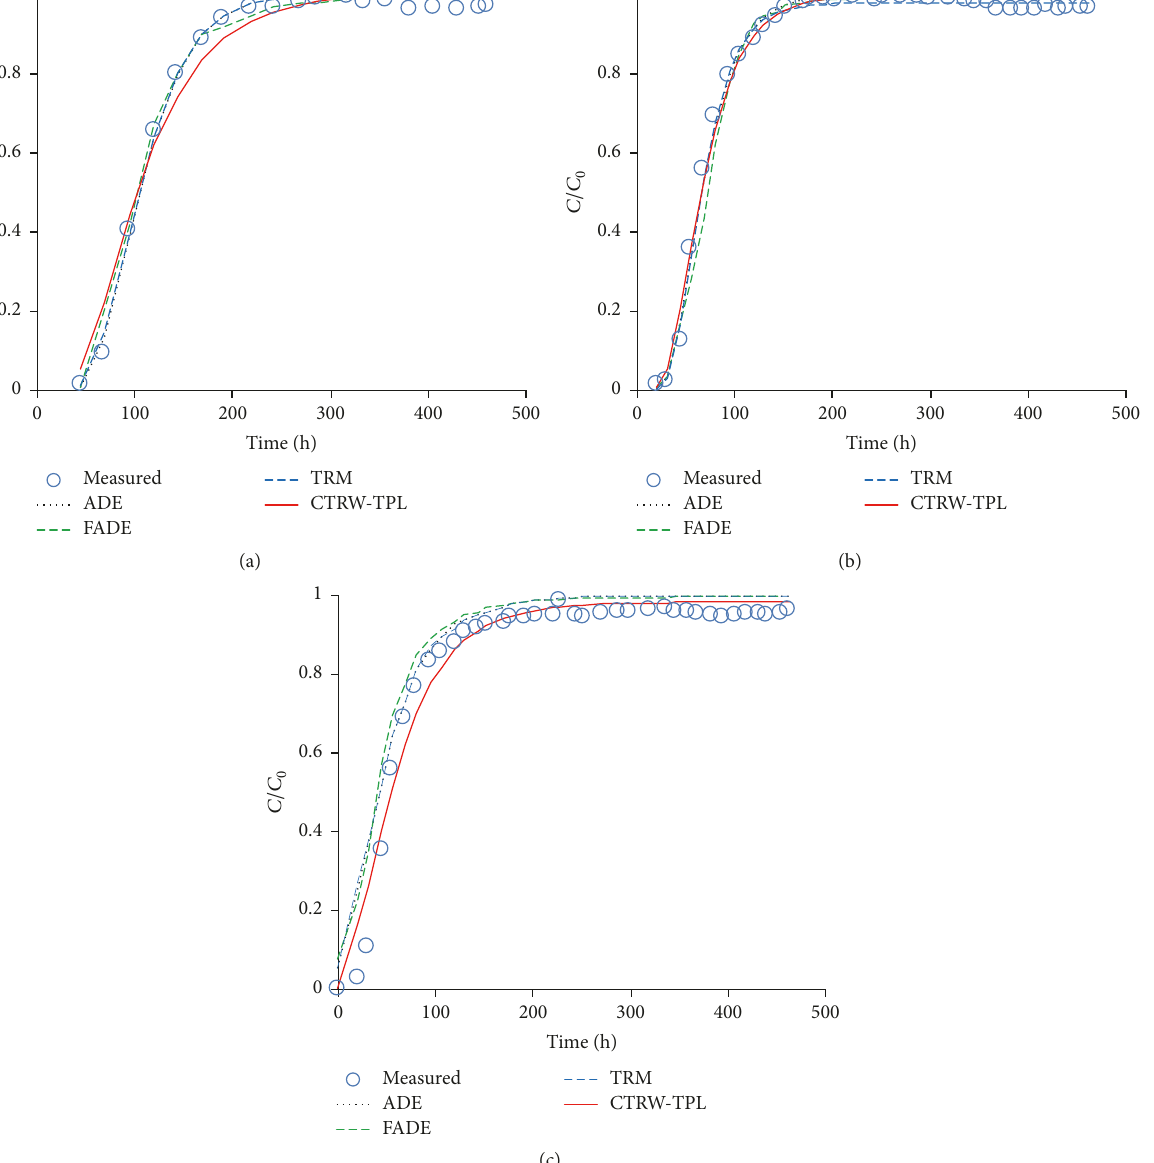
Figure 4: Three sets of measured breakthrough curves fitted with ADE, FADE, TRM, and CTRW (based on TPL), for the homogeneous, saturated, and smooth wall soil column with the same column lengths (5 cm) but different column inner diameters: (a) 7 cm; (b) 9cm; (c)